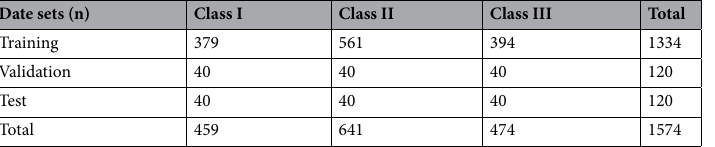
Table 2. The number of patients assigned to training, validation, and test sets for deep convolutional neural network- (DCNN-) based AI model.